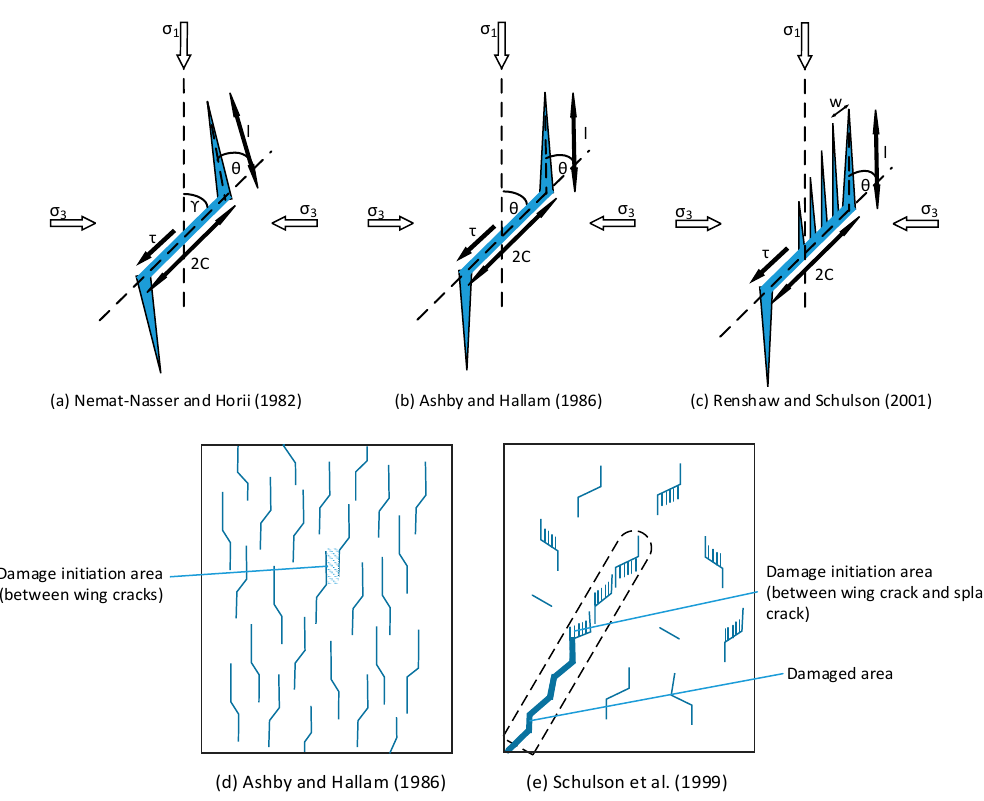
Figure 13. Simple 2D microcrack models developed [92,95–97]: ( a ) Nemat-Nasser and Horii wing crack model [92]; ( b ) Ashby and Hallam wing crack model [97]; ( c ) Renshaw and Schulson wing crack model [95]; ( d ) Failure mechanism proposed by Ashby and Hallam [97]; ( e ) Failure mechamism proposed by Schulson [96].